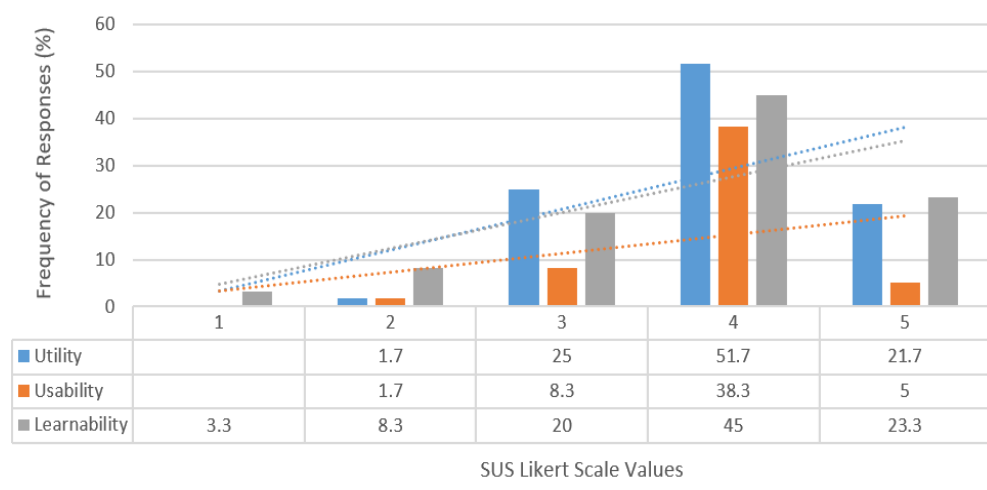
Figure 10. Frequency of perceived preferences regarding the three SUS